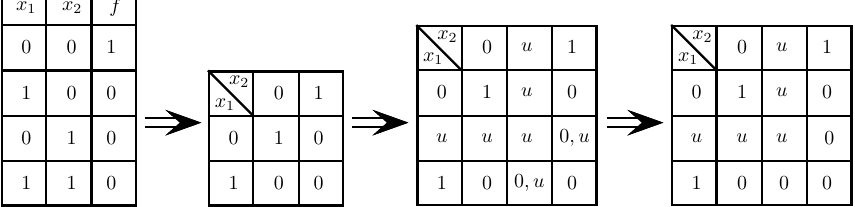
Figure 3. Example of the extension from bivalent to trivalent tables meeting regularity conditions.